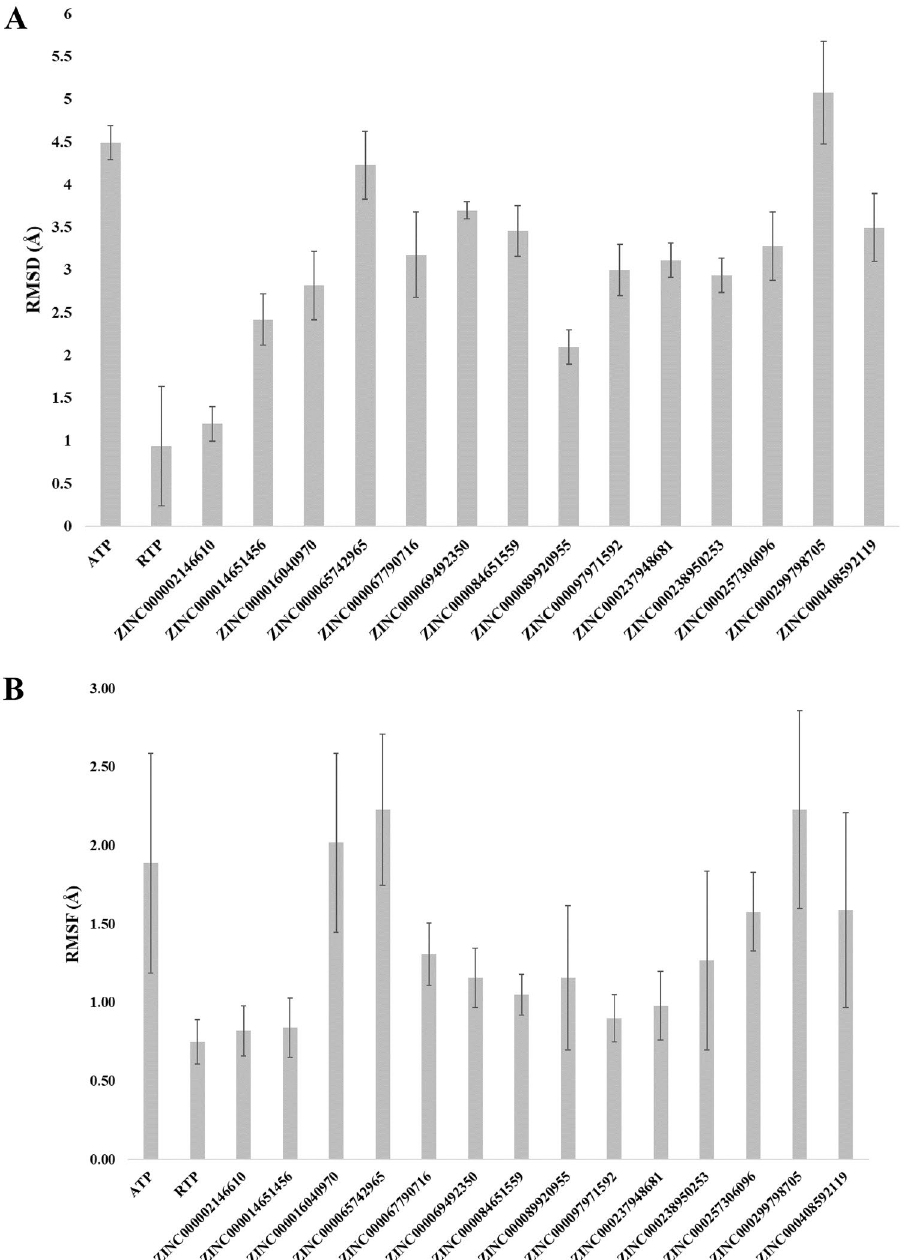
Figure 5. Average ligand RMSD values of all tested systems over the last 100 ns of simulation time ( A ). Average ligand RMSF of SARS-CoV-2 RdRp for all tested systems ( B